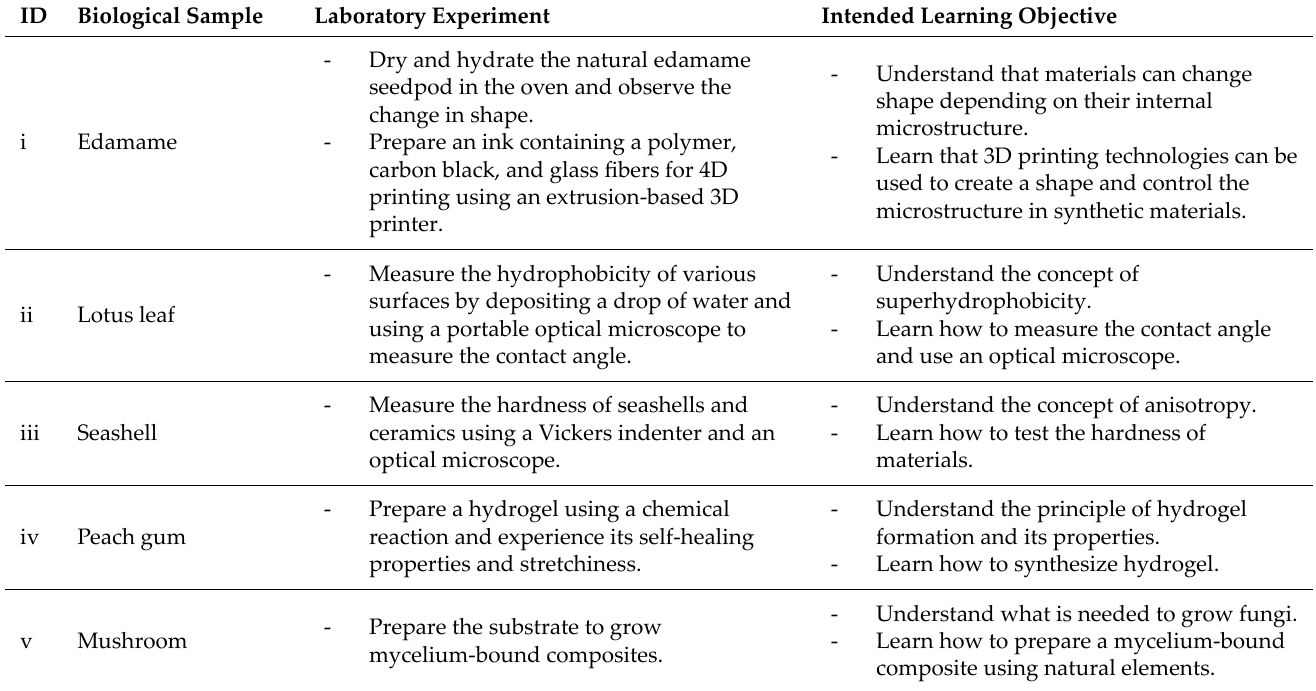
Table 2. Details of active learning session and its learning